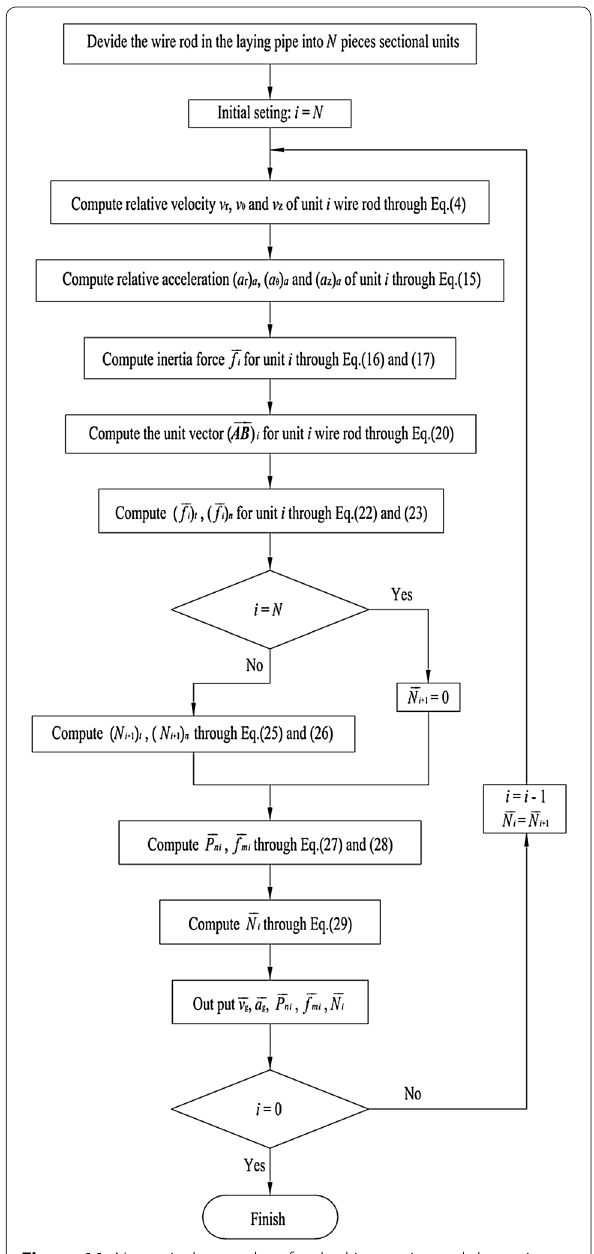
Figure 11 Numerical procedure for the kinematics and dynamics